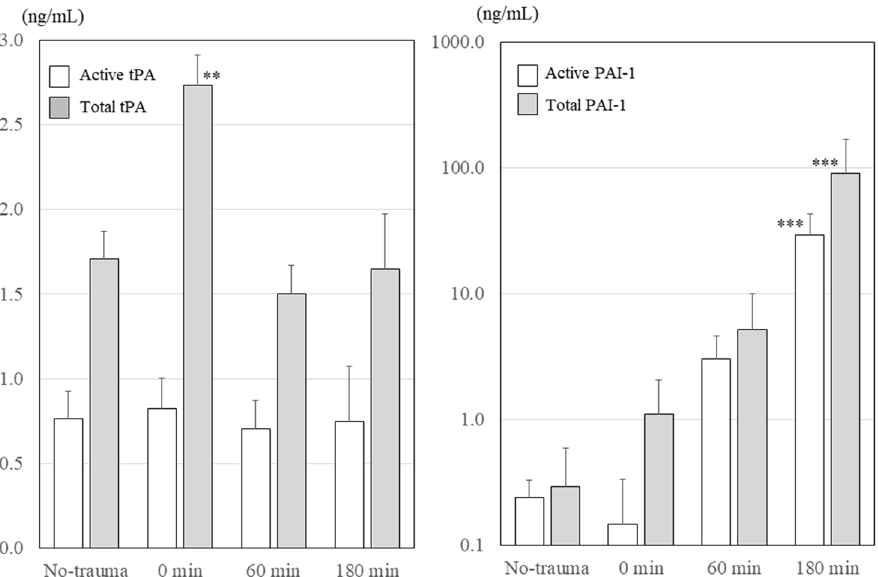
Figure 2. Changes in plasma tPA and PAI-1 levels. Although total tPA levels increased immediately after trauma (0-min group) ( P < 0.001, one-way ANOVA), active tPA levels did not change after trauma.